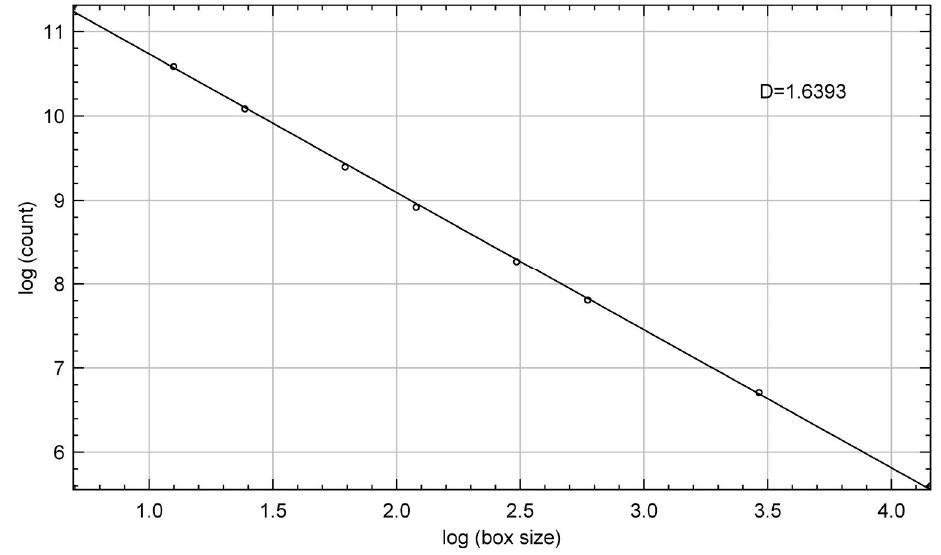
Figure 6. Fractal dimension of dendritic pattern simulated by 30,000 particles (as shown in Figure